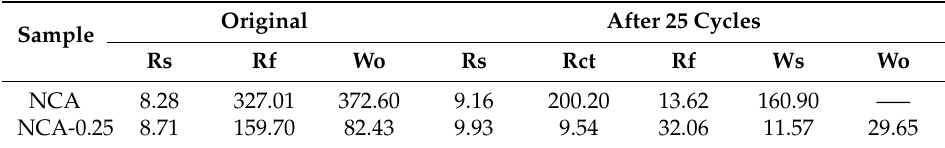
Figure 7. Electrochemical impedance spectra (EIS) of the lithium ion cells assembled with different electrodes, which were obtained before discharge ( a ) and after 25 cycles at 1 C rate ( b ). All impedance data were obtained at 4.3 V. Table 3. Independent resistive components of the pristine NCA sample and NCA-0.25 samples analysed using an equivalent circuit.